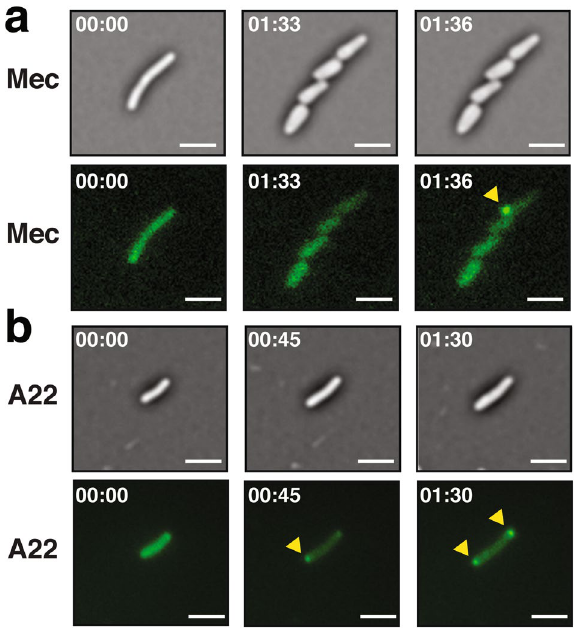
Figure 5. Re-localisation of Intimin-FAST upon antibiotic treatments. ( a ) Treatment with 100 µg/mL of mecillinam (Mec) to target PG organisation. Brightfield (top row) and TIRF (bottom row) images of exponentially growing (OD 600 = 0.7) E. coli harbouring the intimin-FAST construct revealed by the permeant fluorogen (HBR-3,5DM). The yellow arrowhead indicates a sudden agglutination of the intimin-FAST proteins. ( b ) Treatment with 100 µg/mL of A22 to target MreB activity. Brightfield (top row) and TIRF (bottom row) images of exponentially growing (OD 600 = 0.7) E. coli harbouring the intimin-FAST construct revealed by the permeant fluorogen (HBR-3,5DM). The yellow arrowheads indicate the accumulation of intimin-FAST proteins at